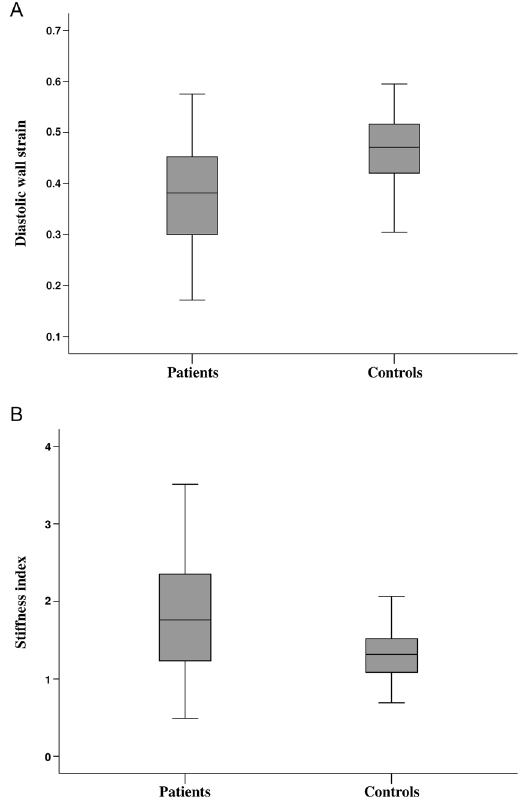
Figure 1. Boxplots showing ( A) diastolic wall strain and ( B ) stiffness index of the left ventricle in patients and controls.